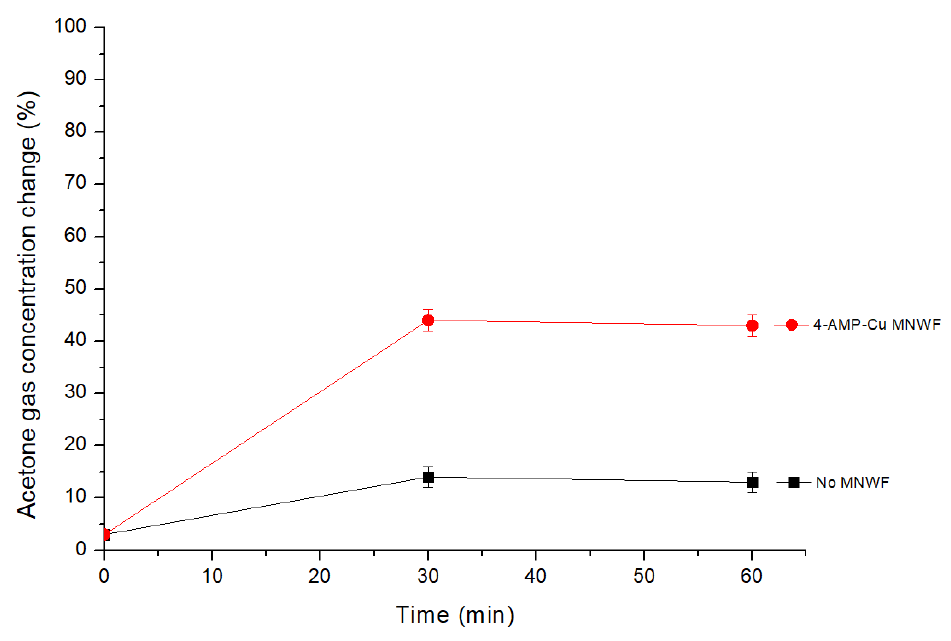
Figure 12. Acetone gas desorption amount of 4-AMP-Cu MNWF (about 50 ppm).